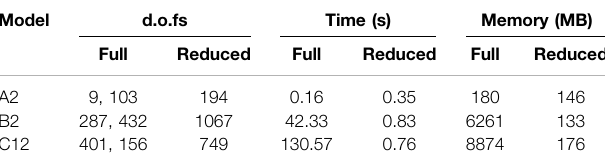
models (2D/3D) and reduced models